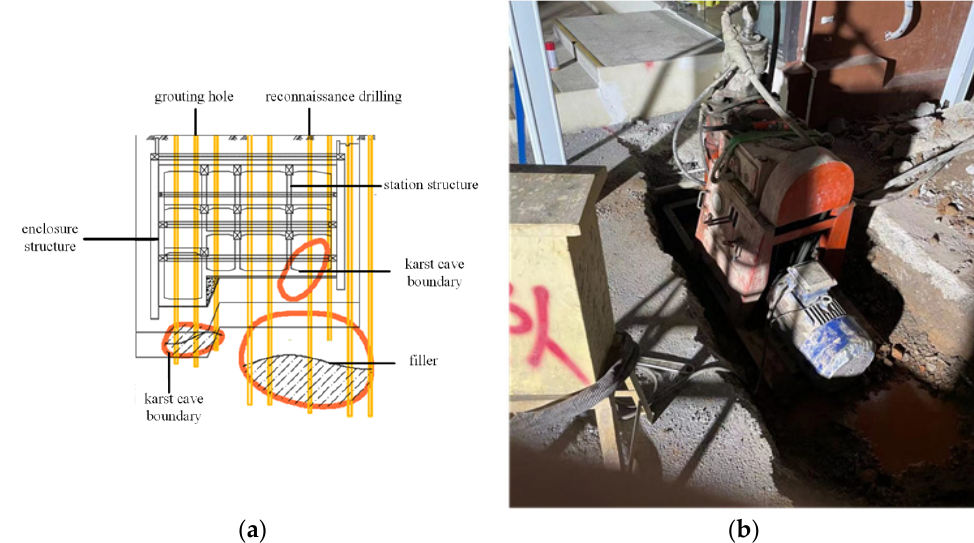
Figure 6. Karst distribution and drilling. ( a ) Karst distribution section map; ( b ) reconnaissance drilling.